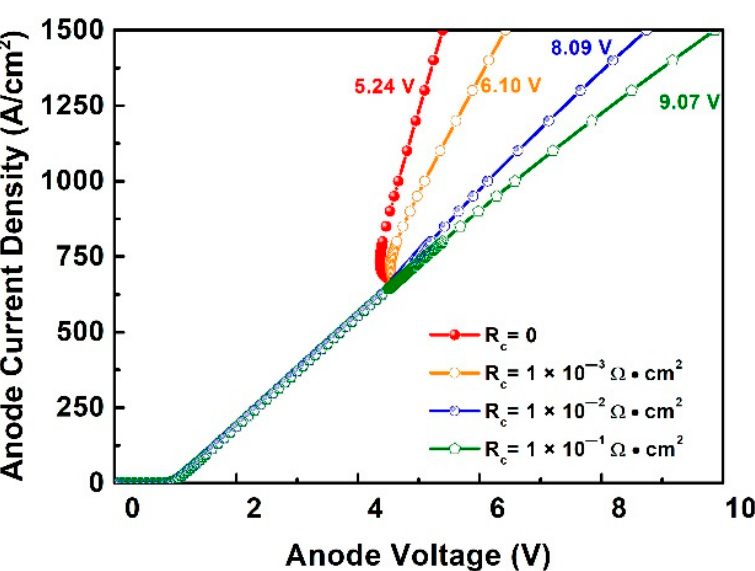
Figure 3. When the contact resistance is low, a snapback phenomenon is observed. And the lower contact resistance leads to lower PN turn-on voltage. The PN junction turn-on voltage at the anode current density of 1384 A/cm 2 , reduces from 9.07 V to 5.24 V when the ohmic contact resistance reduces.